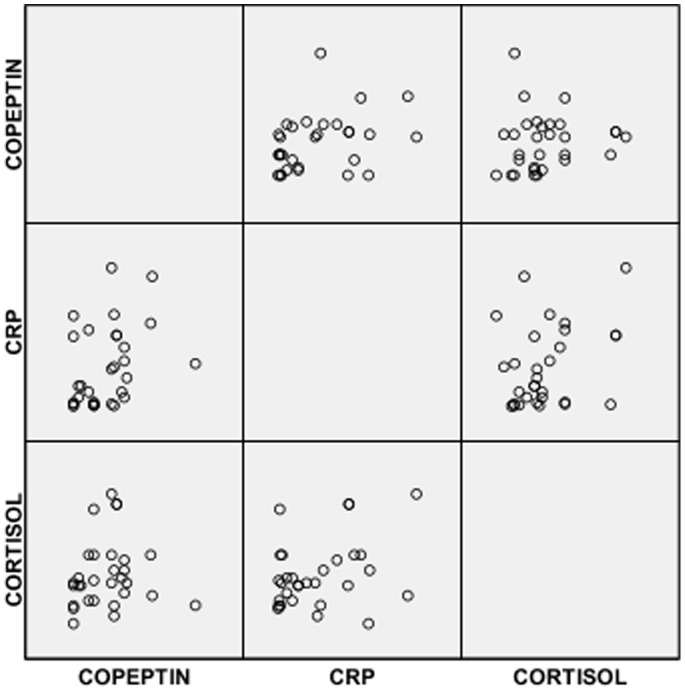
Scatter plots for CRP, copeptin and cortisol in SCA subjects in steady state.